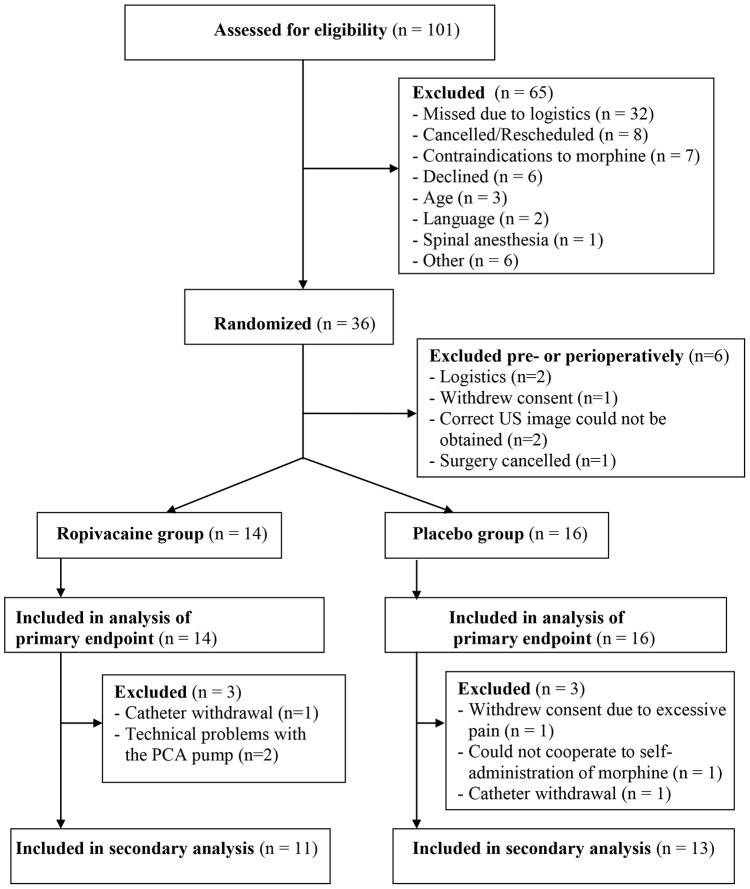
Flow diagram of patient distribution.US =  ultra sound. PCA =  patient-controlled analgesia.